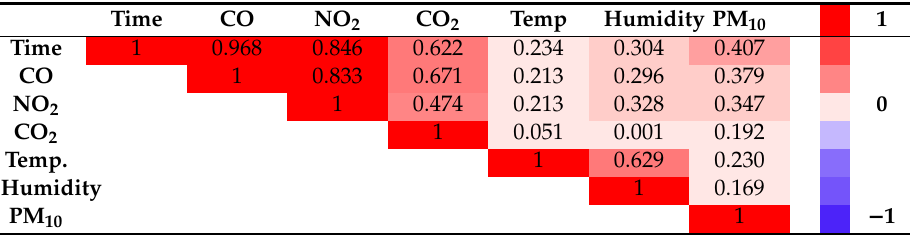
Table 5. Linear correlation matrix for period